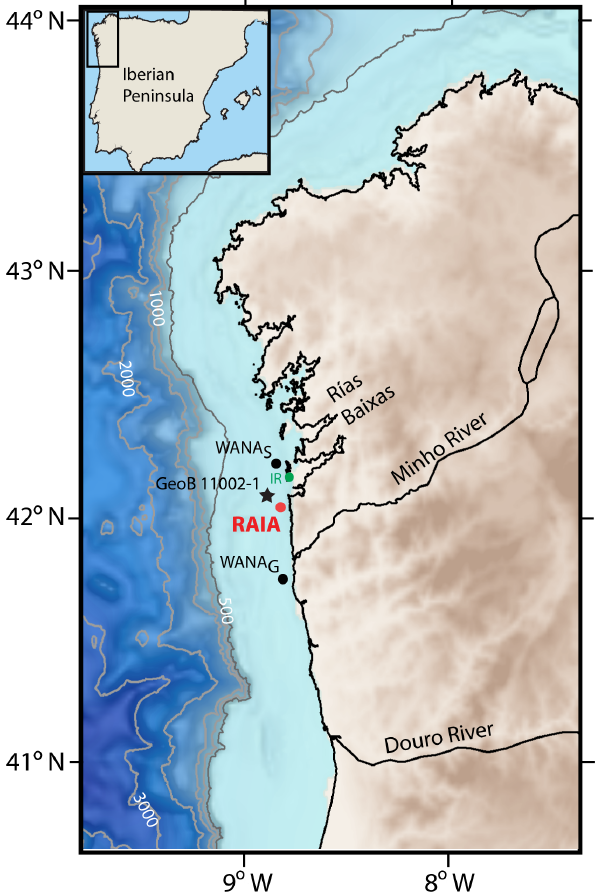
Figure 1. Map of the NW Iberian Peninsula continental margin showing the position of the mooring line (RAIA) site. WANA hind- cast reanalysis points 3027034 (WANA S , off Cape Silleiro) and 1044067 (WANA G , off A Guarda) from which wave data were ob- tained, location of the irradiance Cíes station (IR) and position of the core-top sediment sample GeoB11002-1 are also